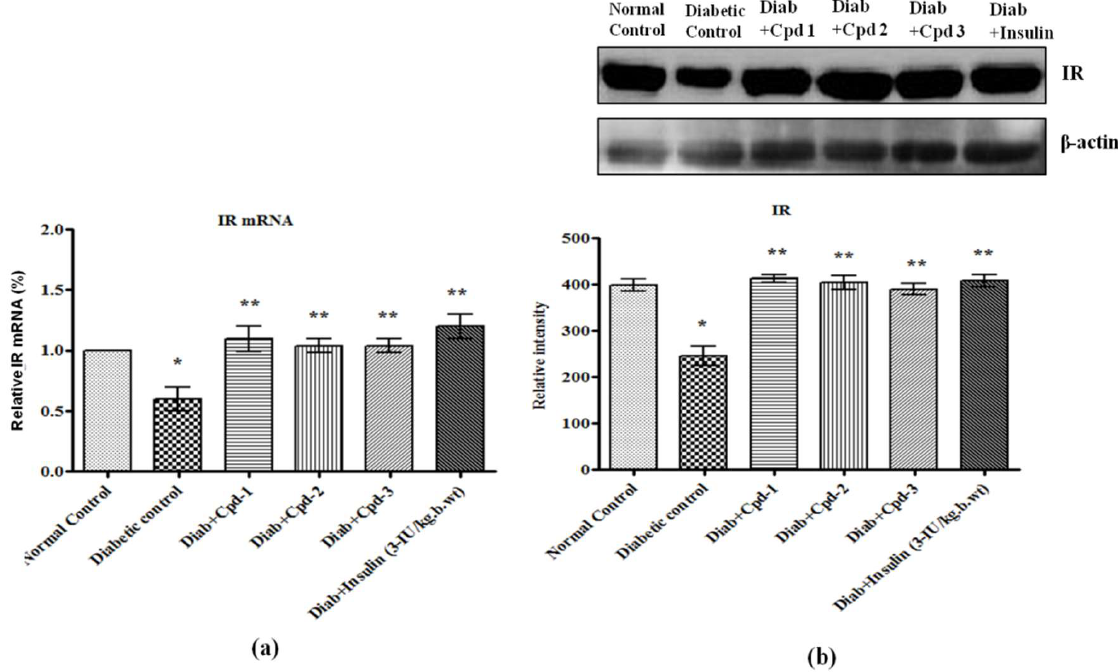
Figure 7. Effect of novel triterpenoids on ( a ) IR mRNA; ( b ) IR protein and its expression in skeletal muscle of STZ-induced diabetic rats compared with the effect of insulin. The expression of mRNA and proteins was assessed by real-time PCR and Western blotting. β-actin was used as a loading control. Each bar represents mean ± SEM of 3 observations representing 6 animals. Significance at p < 0.05; *, compared with control, **, compared with diabetic control.